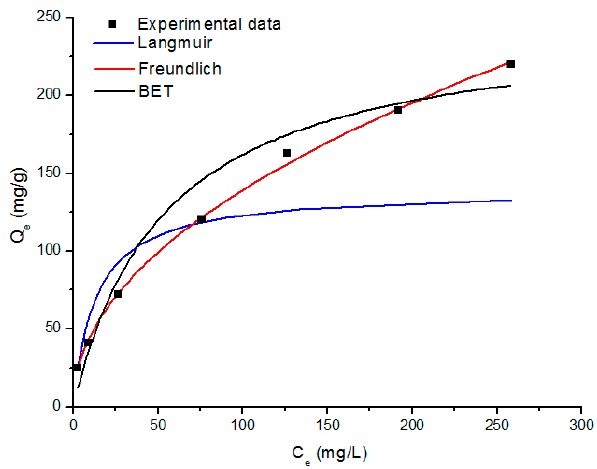
Figure 10. Adjustment of the Langmuir, Freundlich and Brunauer–Emmett–Teller (BET) models to the experimental data obtained from the SS/KL blend beads. Table 2. Isotherm constants and correlation coefficients for the biosorption of Cr(VI).